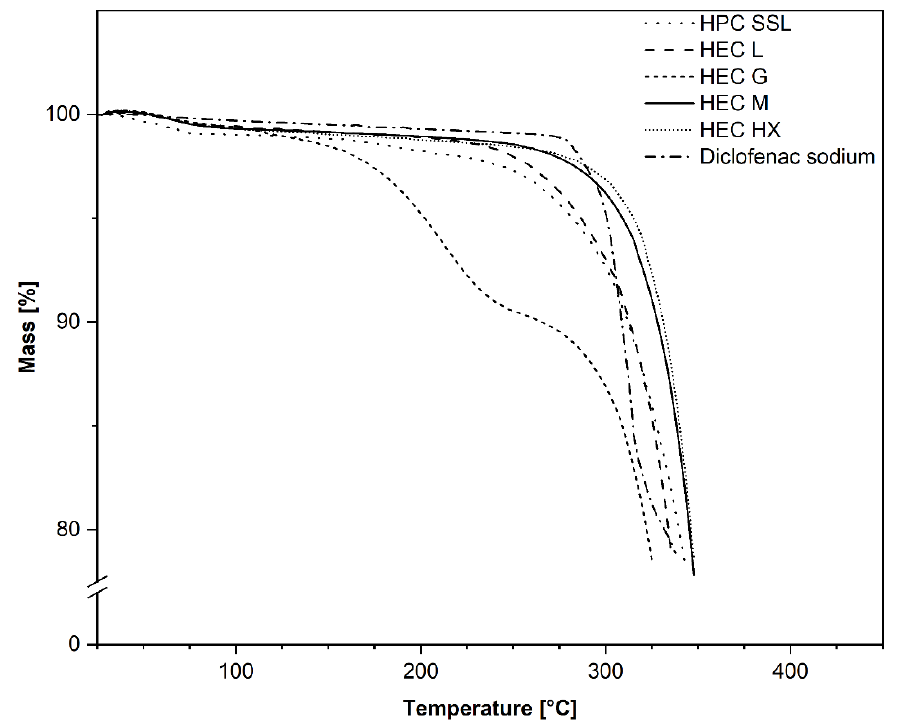
Figure 1. Thermogravimetric analysis of different raw excipients, using a TG 209 F1 Iris device with 20 K·min −1 heating rate and 20 mL·min −1 nitrogen flow.